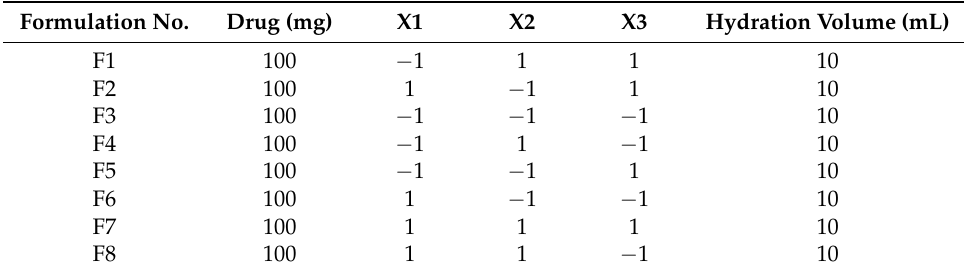
Table 2. The designed formulations of MIC